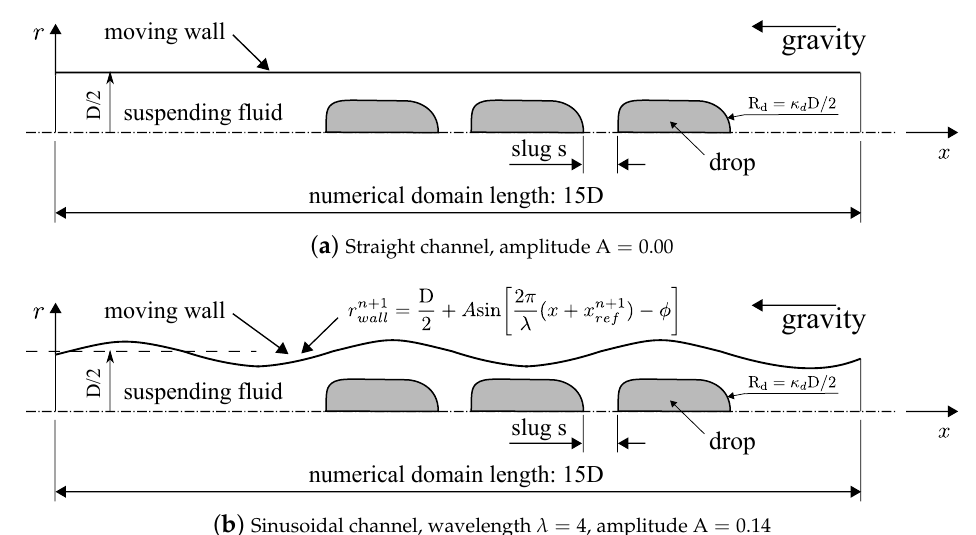
Figure 2. Geometries of the straight and sinusoidal channels used in this work. Note that the straight channel is obtained by setting the amplitude of the sinusoidal channel to A = 0.00. One and three drops were used in this work, with liquid slug s of 0.375 ≤ s ≤ 1.875 where D is the drop’s diameter. κ d = 1.75 is the drop’s size factor relative to the channel’s radius (D/2) where the following relation remains R d = κ d D/2, with R d as the drop’s radius. All parameters are